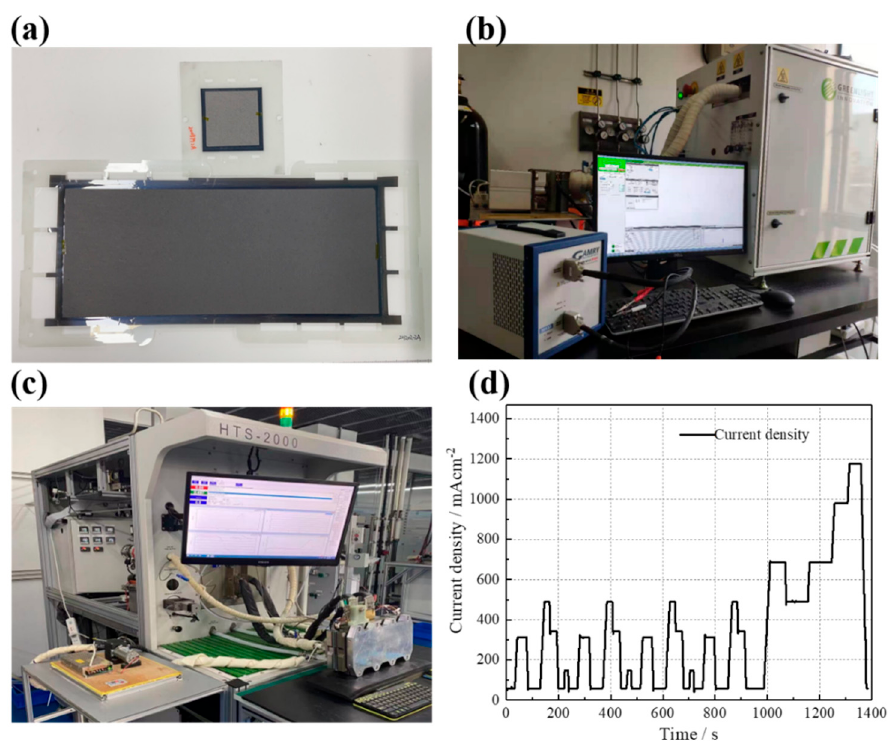
Figure 1. ( a ) 25 cm 2 MEA, and 340 cm 2 MEA; ( b ) Greenlight G20 and Gamry reference 3000; ( c ) HTS- 2000 (HepHas Energy), and 3-cell stack; ( d ) dynamic load cycle used in 1003-hour durability test.